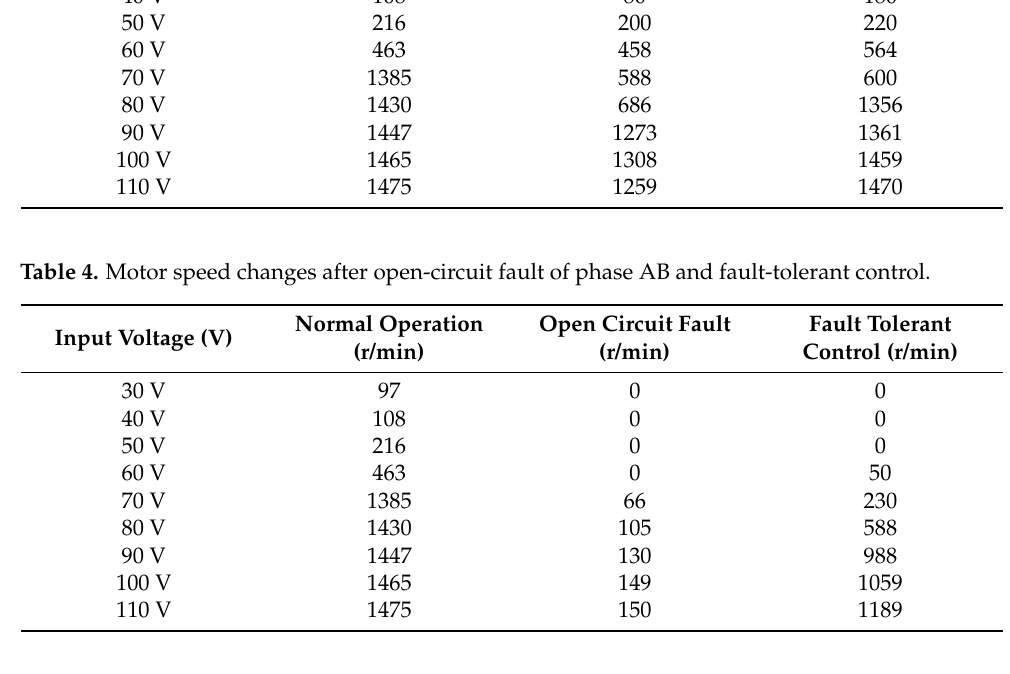
Table 5. Motor speed changes after open-circuit fault of phase AC and fault-tolerant